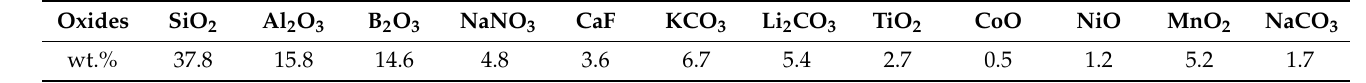
Table 2. Chemical composition of the enamel powder used in this